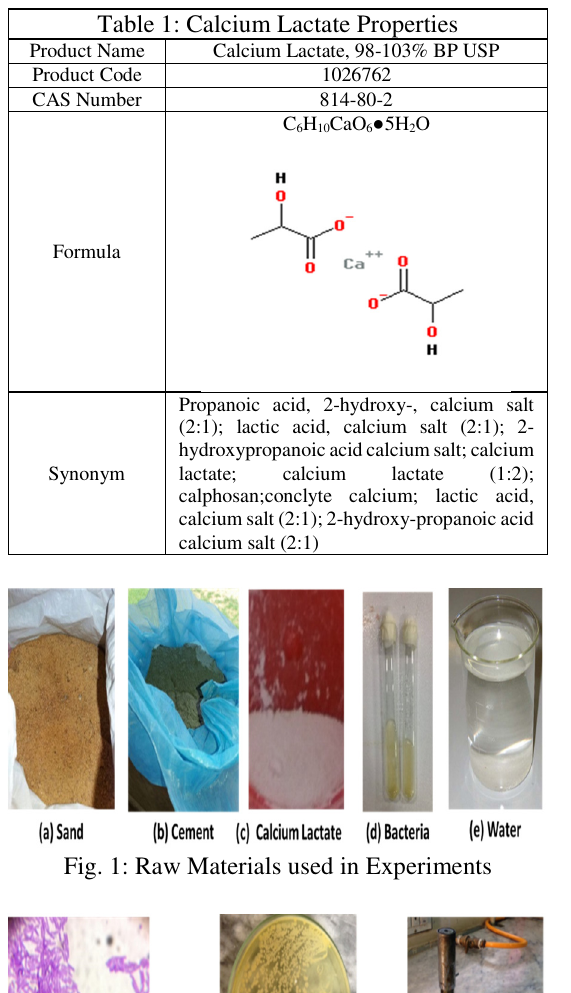
Fig. 1: Raw Materials used in Experiments